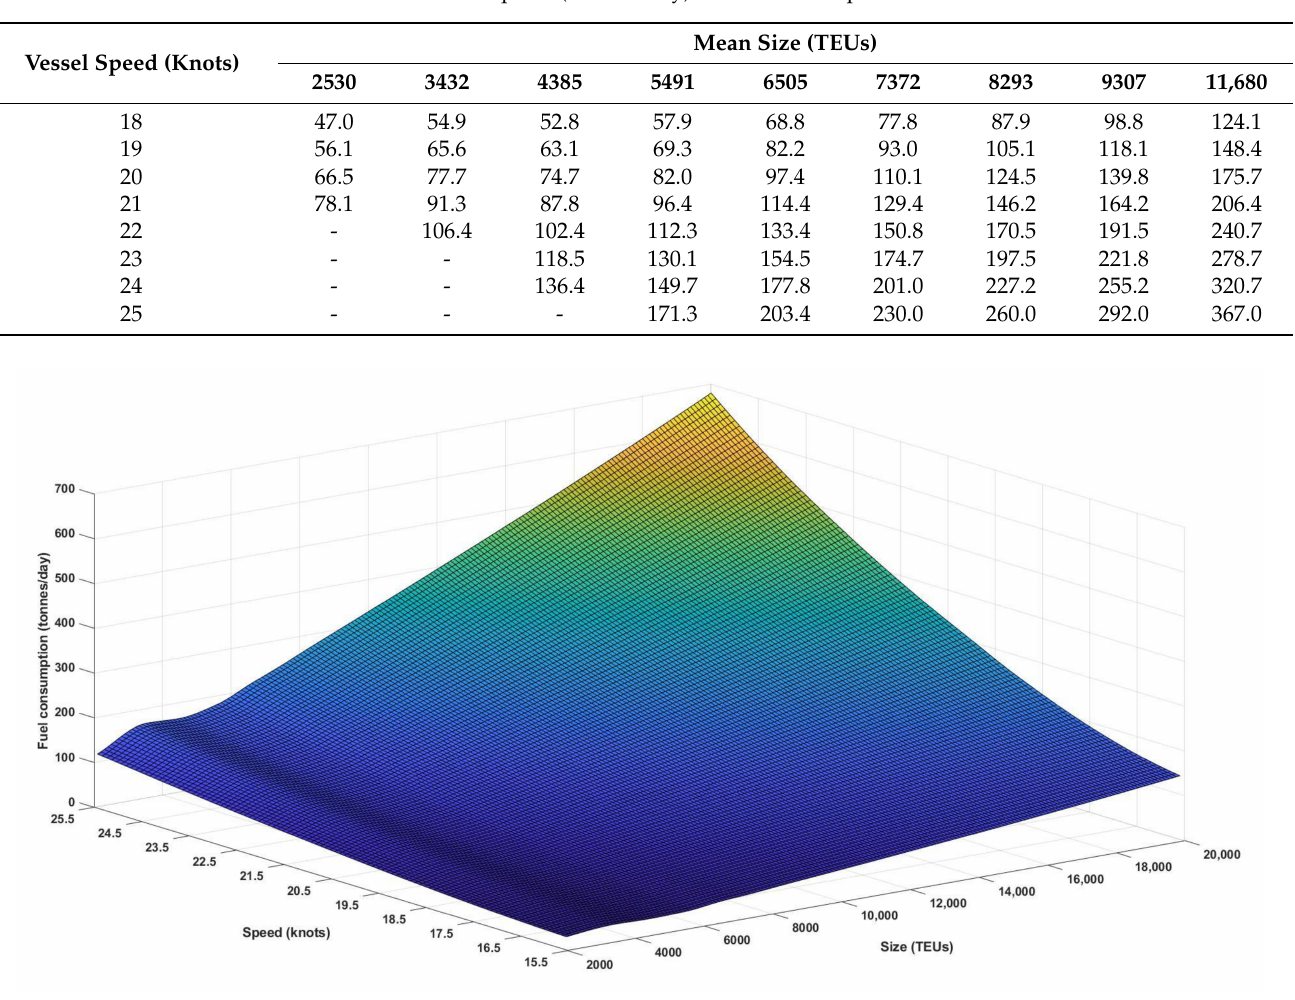
Figure 3. Fuel consumption (FC(VS,SS)) as function of size (TEUs) and speed